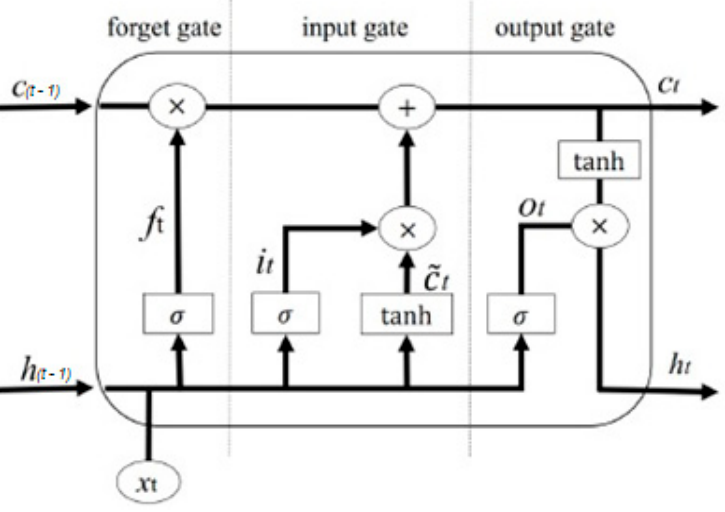
Figure 1. Long short-term memory cell [25].